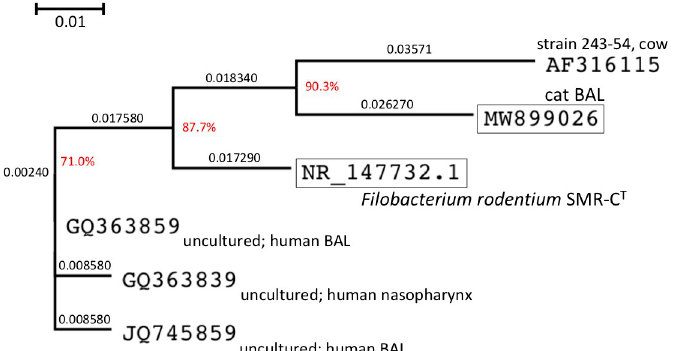
Fig 1. Neighbour-joining phylogenetic tree based on 16S rRNA gene sequences showing the relationships of the organism derived from cats and other Filobacterium spp. Bootstrap values are displayed in red, based on 1,000 replicates. Bar, 0.01 substitutions per nucleotide position. MW899026 (representative 16S rDNA sequence data of the organisms derived from the three cats) is alligned using ClustalW program with Filobacterium rodentium SMR-C T (type strain and type genus) 16S rRNA gene reference sequence (NR_147732.1) and sequences of putative Filobacterium spp. listed in SILVA SSU r138.1. The aligned data were trimmed by manual inspection (nucleotide position 774 to 891 of NR_147732.1).